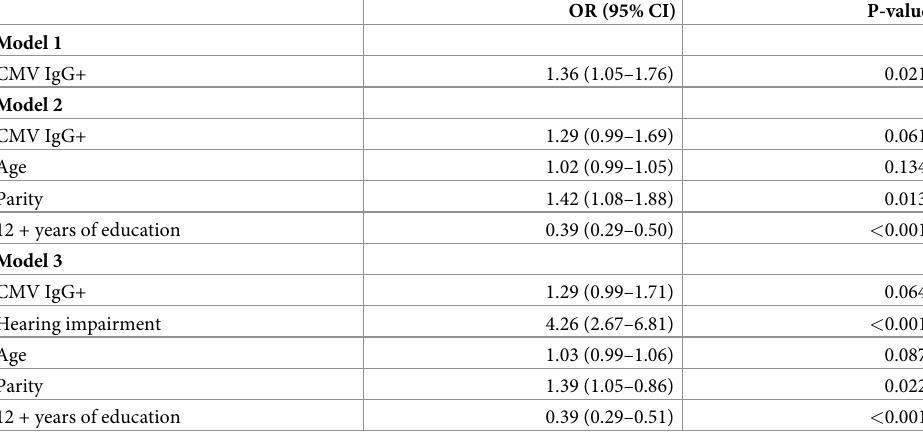
Table 5. Results from logistic regression modelling, with crude and adjusted odds ratios for the association between CMV IgG+ and delayed language